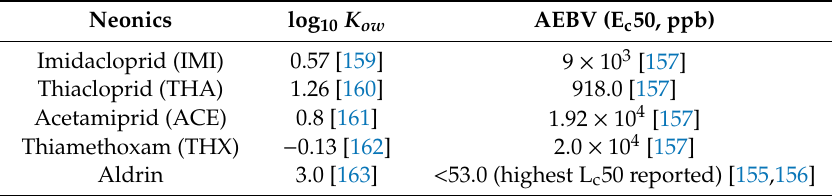
Table 8. Octanol-water partition coe ffi cients of pesticides at room temperatures 20 to 25 ◦ C.